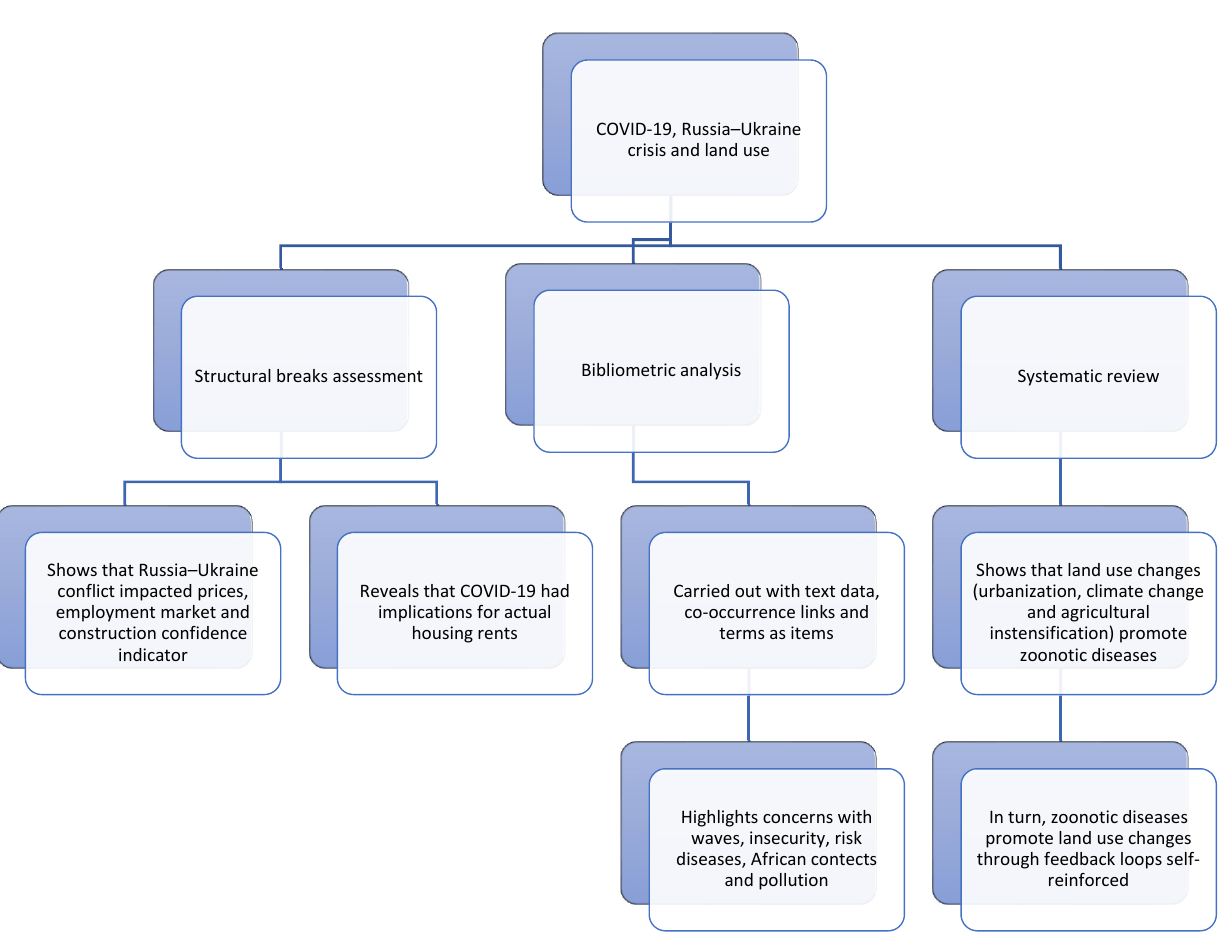
Figure 7. Main results of this research obtained via structural breaks analysis, bibliometric assessment and systematic literature review.